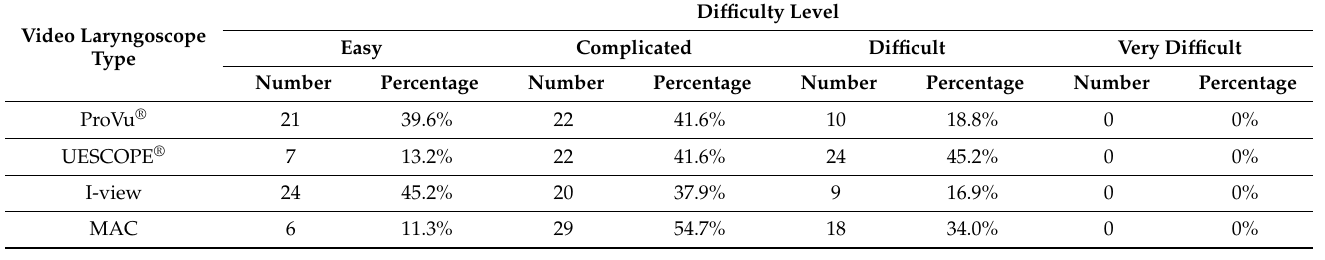
Table 3. The difficulty level of each (video) laryngoscope. Chi 2 ANOVA (N = 32, df = 3) = 15.50870, p = 0.00143.